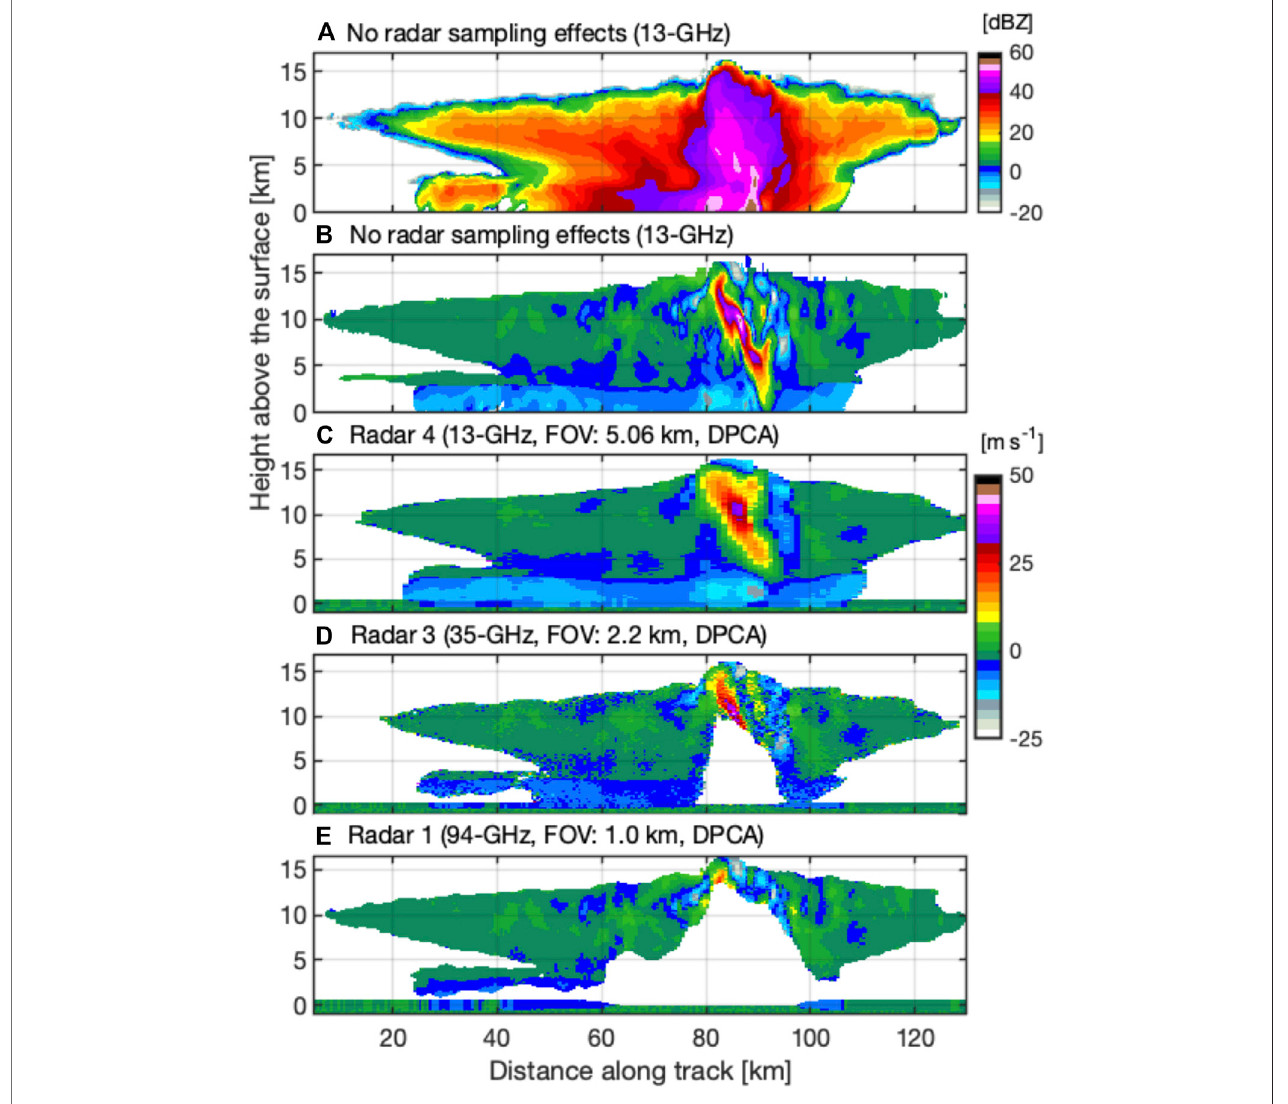
FIGURE 9 | Forward simulation of MC3E deep convection (A) radar re fl ectivity at 13 GHz without radar sampling effects (B) mean Doppler velocity at 13 GHz without radar sampling effects (i.e., truth) as well as mean Doppler velocity for (C) radar 4, (D) radar 3, and (E) radar 1.